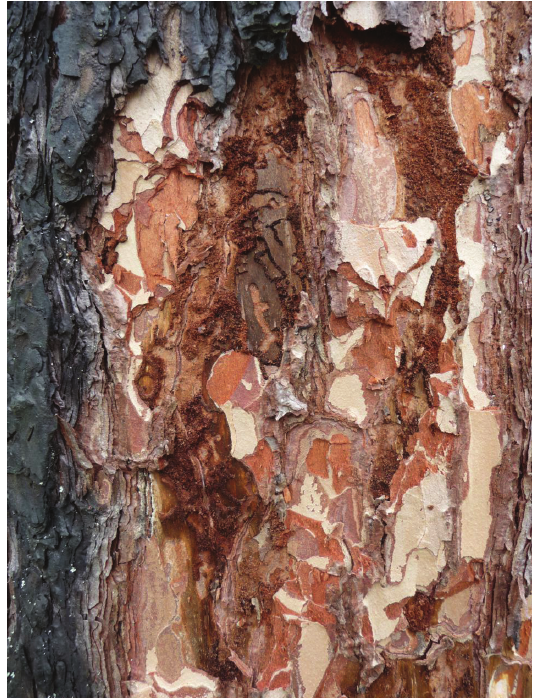
Figure 4. Larval galleries of Stephanopachys linearis in the Scots pine bark (photo by J. Borowski,